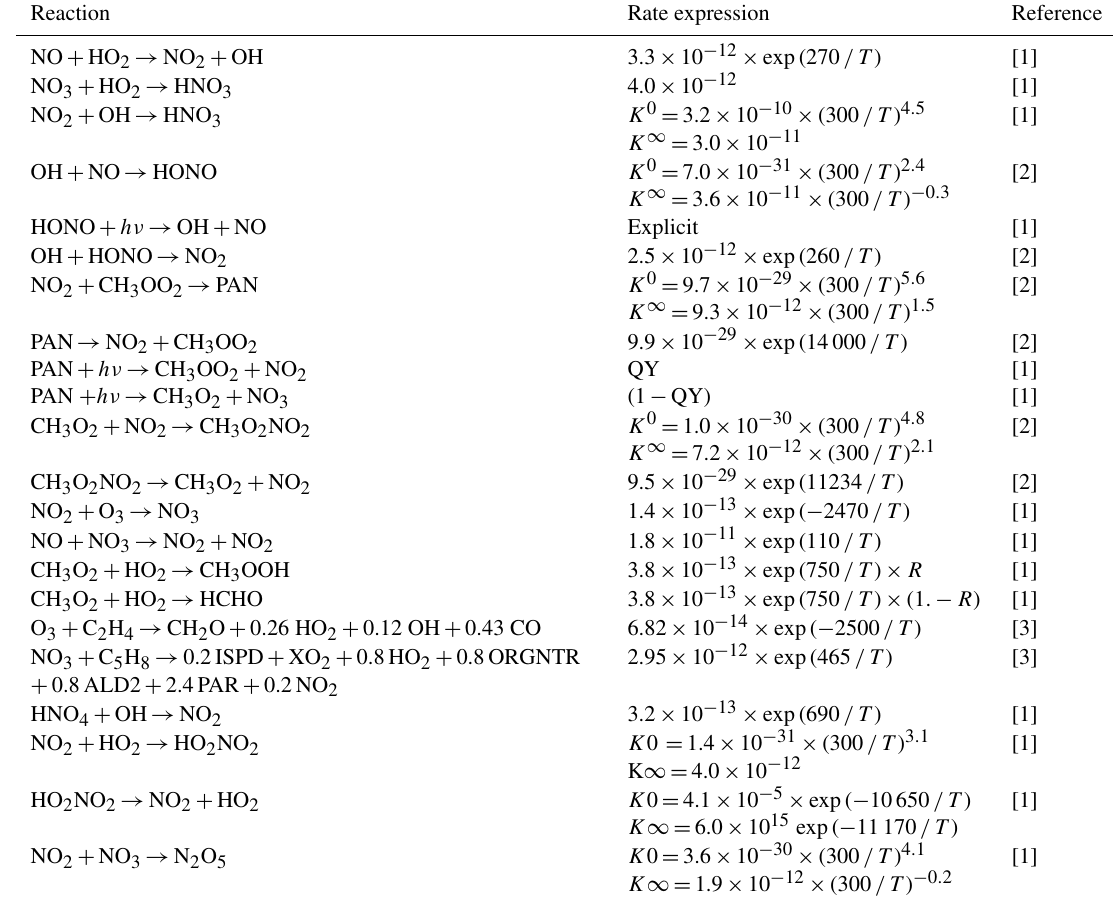
Table 2. Updates to the NO x reaction chemistry in CBA as compared to Huijnen et al. (2019). Reaction Rate expression